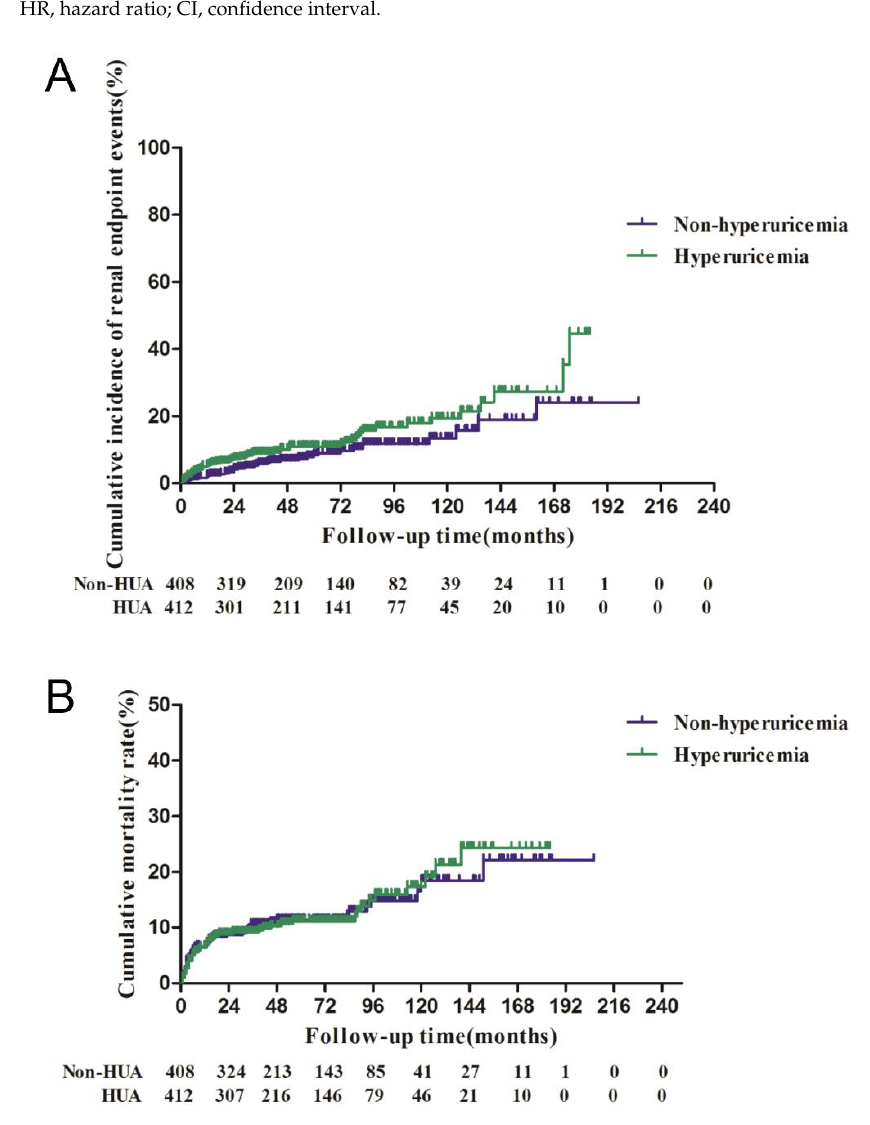
Figure 1. Kaplan–Meier survival functions of LN (lupus nephritis) patients with hyperuricemia (HUA) and without hyperuricemia. ( A ) Log-rank significance for renal endpoint events = 0.073; ( B ) Log-rank significance for death = 0.955.